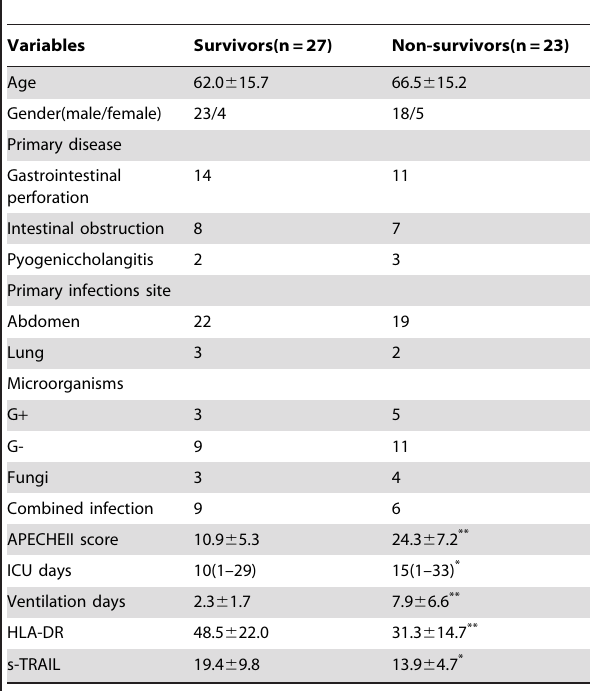
Table 1. Clinical characteristics and biochemical data of septic patients.